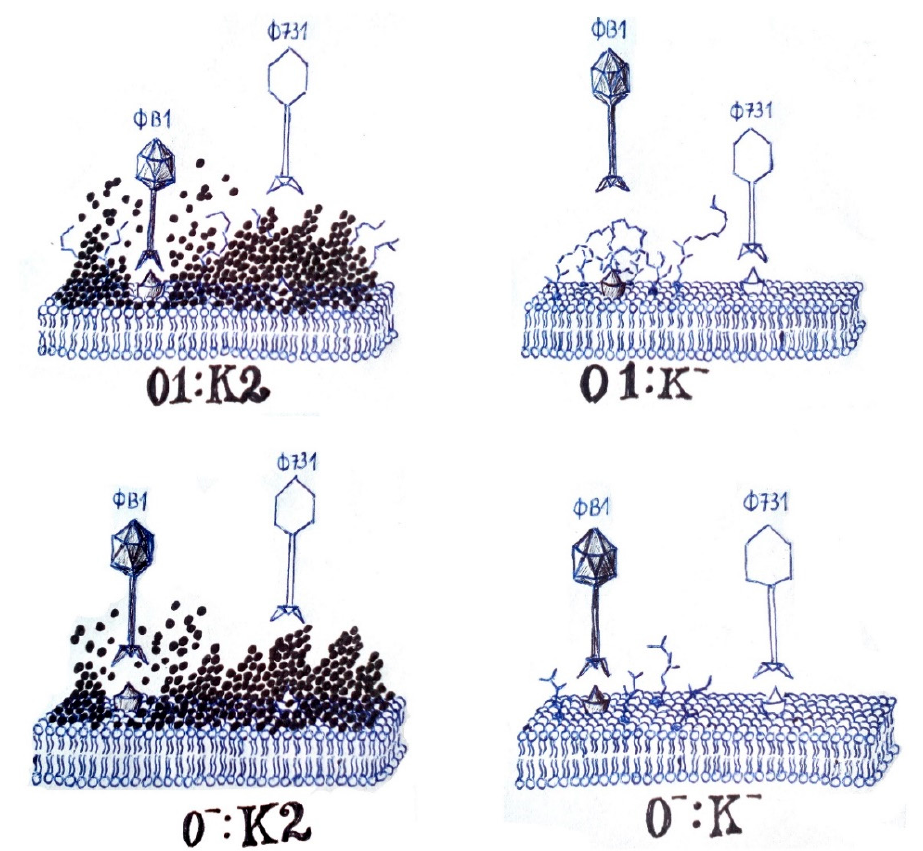
Figure 7. Hypothetical representation of the effect of phage B1 and 731 on K. pneumoniae 52145 wild-type and isogenic mutants. Upper left: wild type (52145); bottom left: LPS mutant (52145- Δ waaL ); upper right: CPS mutant (52145- Δ wca K2 ); bottom right: LPS-CPS double mutant (52145- Δ wca K2 Δ waaL ). Phage efficiency is represented by the distance of the phage to the membrane. Outer membrane is represented as cross-segment, peaky spots are OMPs (irreversible receptors), LPS and long O antigen chains are represented by zig-zags, CPS is represented by the black dots.